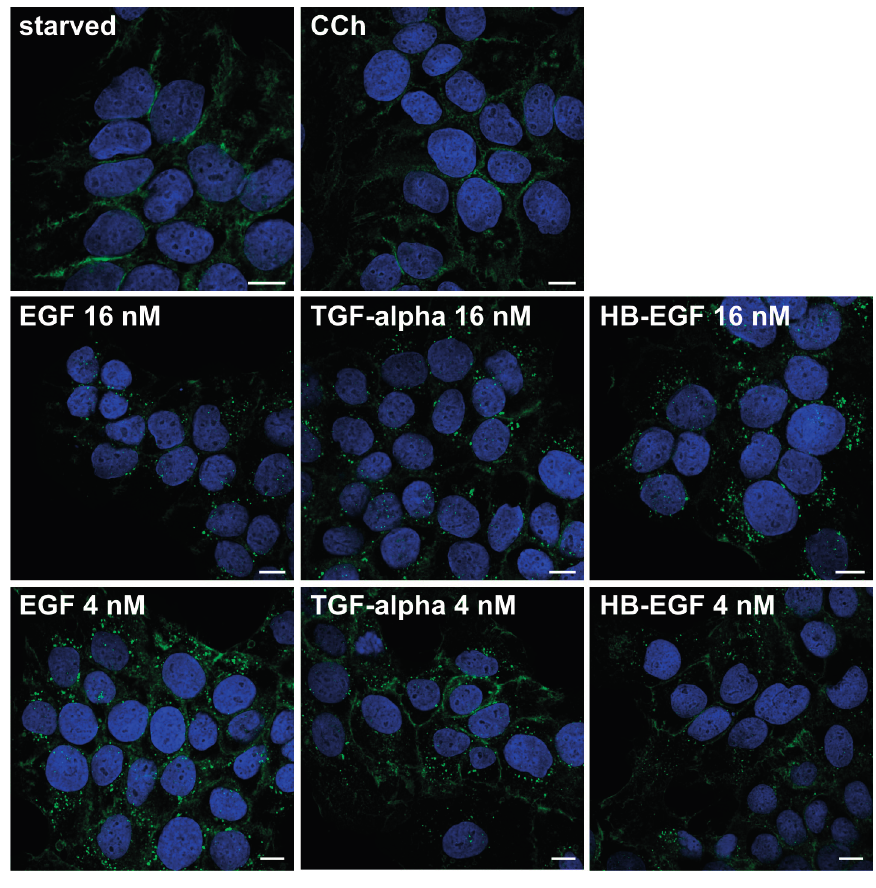
Figure 7. Cholinergic stimulation does not induce EGFR endocytosis, whereas EGF, TGF- α and HB-EGF do. EGFR localization after CCh, EGF, TGF- α and HB-EGF treatment was studied using immunofluorescence staining. Serum-starved HaCaT cells were stimulated with 1 mM CCh, 16 or 4 nM EGF, TGF- α or HB-EGF for 30 min. Cells were fixed with methanol and immunostained for EGFR. Nuclei are shown in blue (DAPI staining). The results are representative of three independent experiments. Scale bar: 10